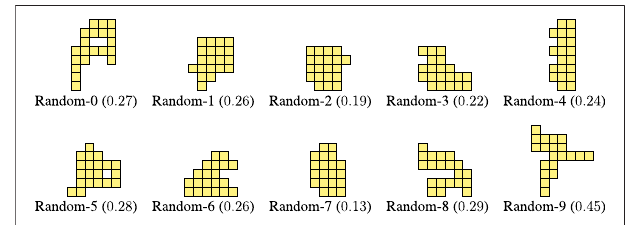
FIGURE 10 | Morphologies generated with the Random procedure together with the corresponding value of